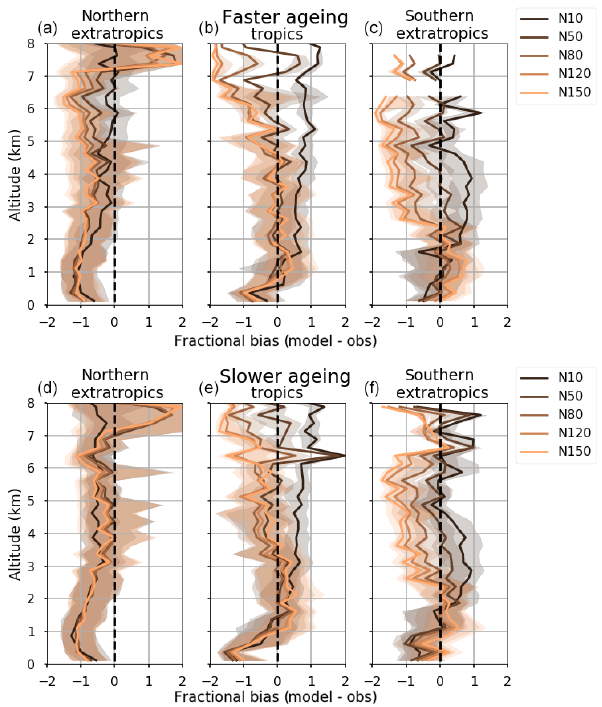
Figure 7. The vertical profile of fractional bias in modelled aerosol number at different size cut-offs for measurements in the north- ern extratropics (a) , the tropics (b) and the southern extratropics (c) with faster (0.3 monolayers required) and slower (five monolay- ers) condensational ageing rates.